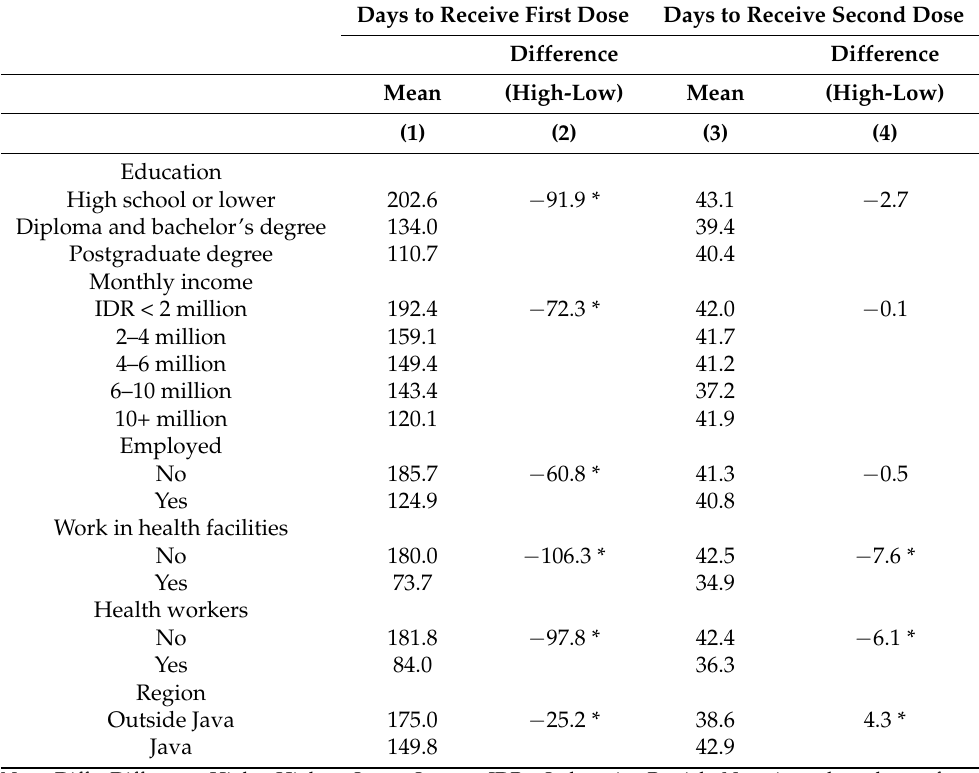
Table 2. Bivariate analysis of inequalities in days to receive first and second doses of the COVID-19 vaccine. Days to Receive First Dose Days to Receive Second Dose Difference Difference Mean (High-Low) Mean (High-Low) (1) (2) (3) (4) Education High school or lower 202.6 − 91.9 * − 2.7